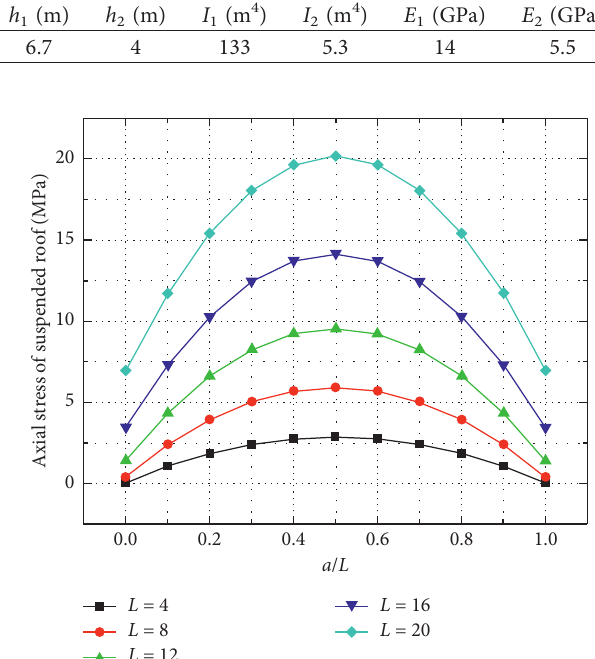
Figure 9: Axial stress of the suspended roof with “ a / L .”